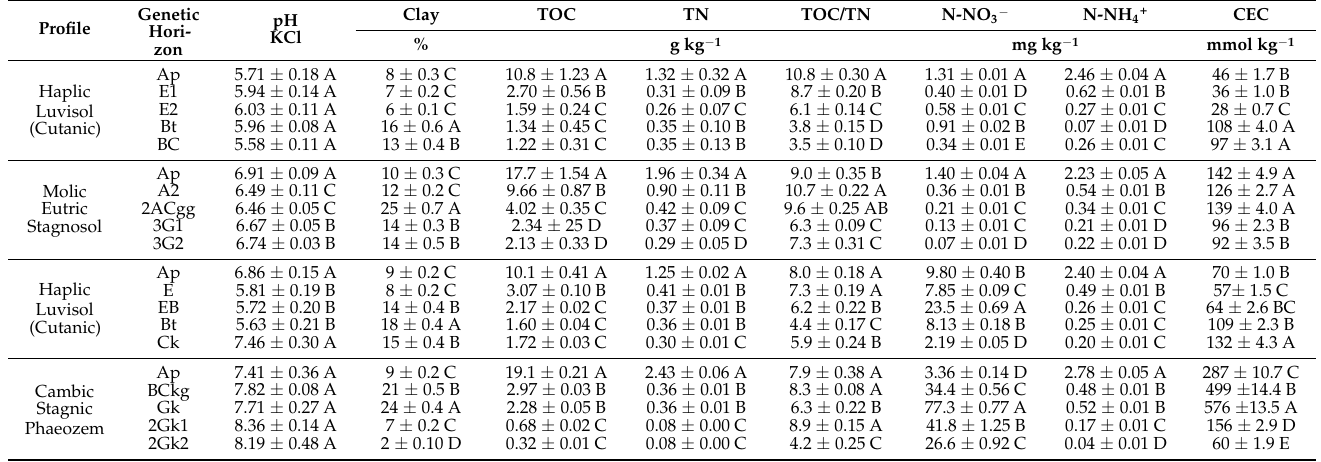
Table 2. Depth distribution of some physico-chemical properties; mean ( ± SE), n =